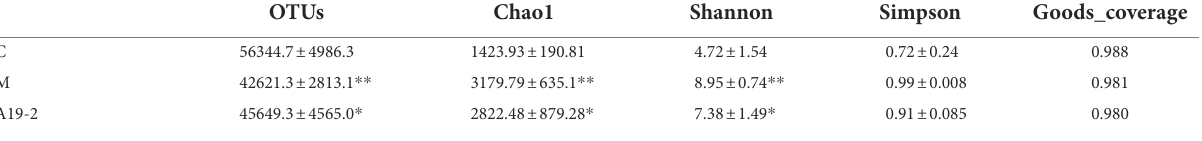
TABLE 2 OTUs and α -diversity indices of microbiota in each group. OTUs Chao1 Shannon Simpson Goods_coverage